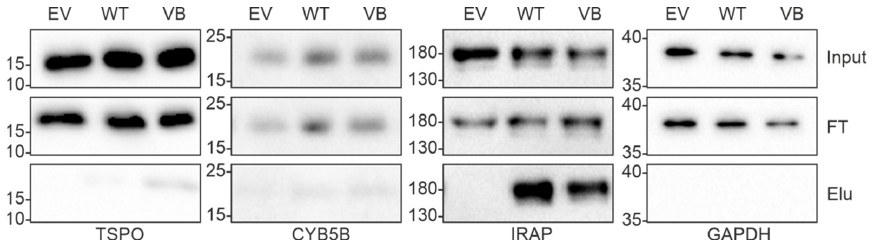
Figure 3. Validation of protein interaction analysis of WT and variant B cystatin C by immunoblotting. Immunoblot analysis of pull down samples from ARPE-19 cells transfected with empty vector (EV), wild-type cystatin C (WT), or variant B cystatin C (VB). Top panels show inputs, middle panels show flow through (FT), and bottom panels show eluates (Elu). GAPDH was used as a negative control. IRAP (encoded by LNPEP ) was pulled down by both WT and variant B cystatin C. Blots shown are representative of three separate experiments.